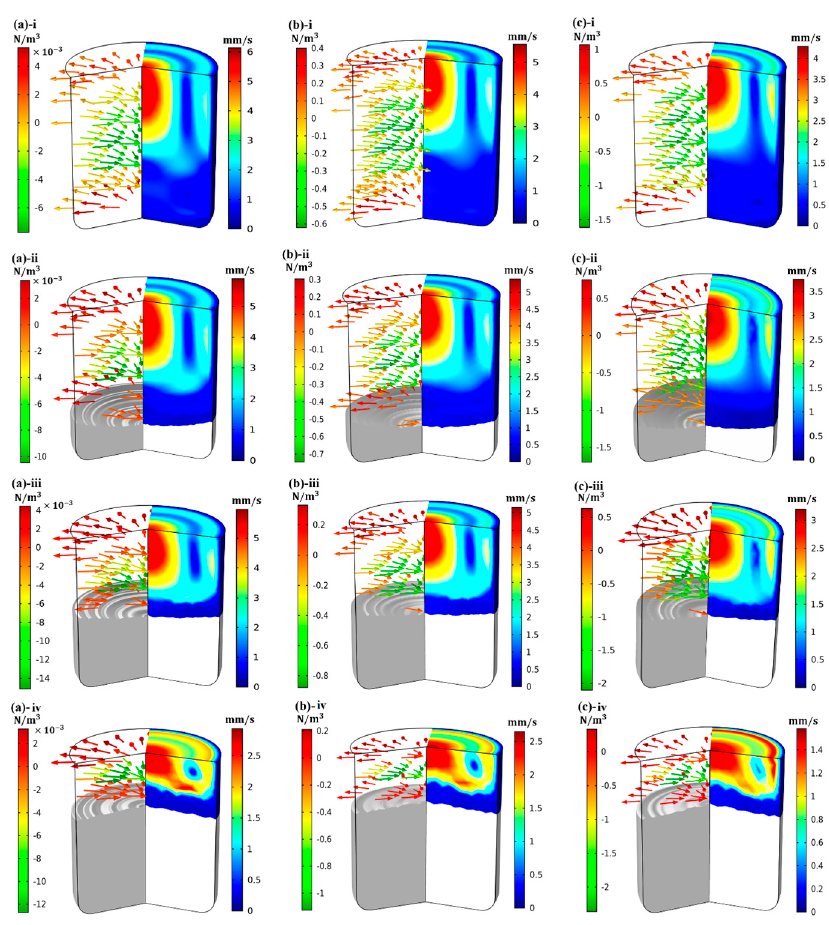
Figure 5. Lorentz force ( left ) and melt flow velocity ( right ) in the silicon melt when the current magnitude is: ( a ) 1 A, ( b ) 10 A, and ( c ) 20 A at ( i ) the beginning, ( ii ) the 45th minute, ( iii ) the 90th minute, and ( iv ) the 120th minute of the crystallization stage.